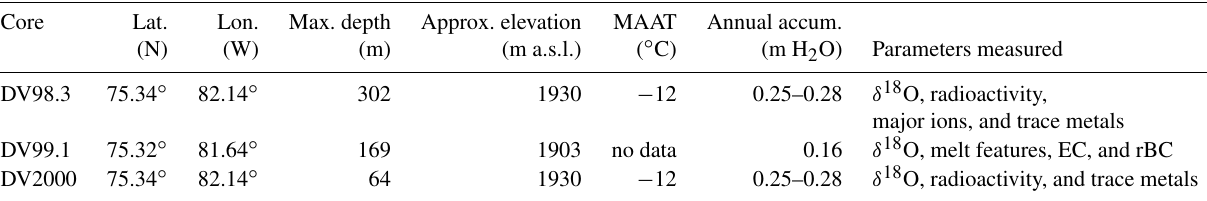
Table 1. Details of the three Devon ice cap cores used in this study. MAAT refers to mean annual surface air temperature. See text for specific references to published